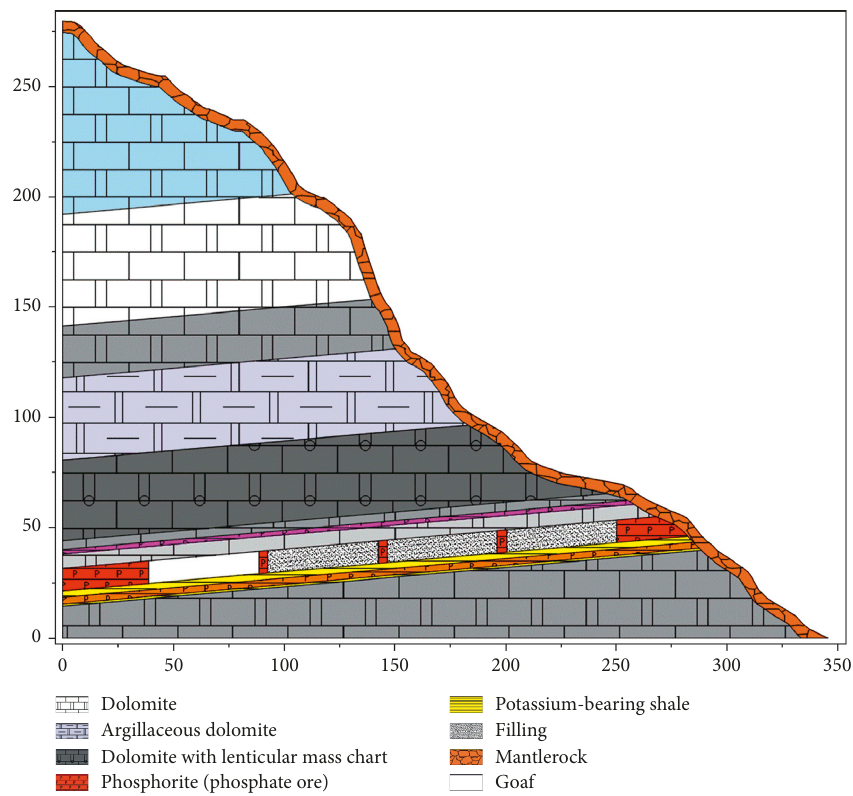
Figure 3: The most dangerous situation of HSRS using backfill mining